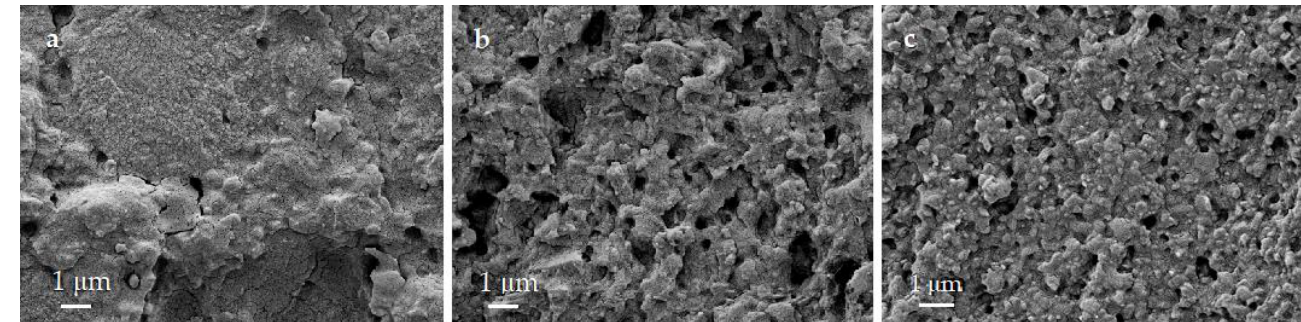
Figure 10. Fracture surfaces of the ( a ) LU, ( b ) BC ( b ), and ( c ) CS materials after a TPB test.